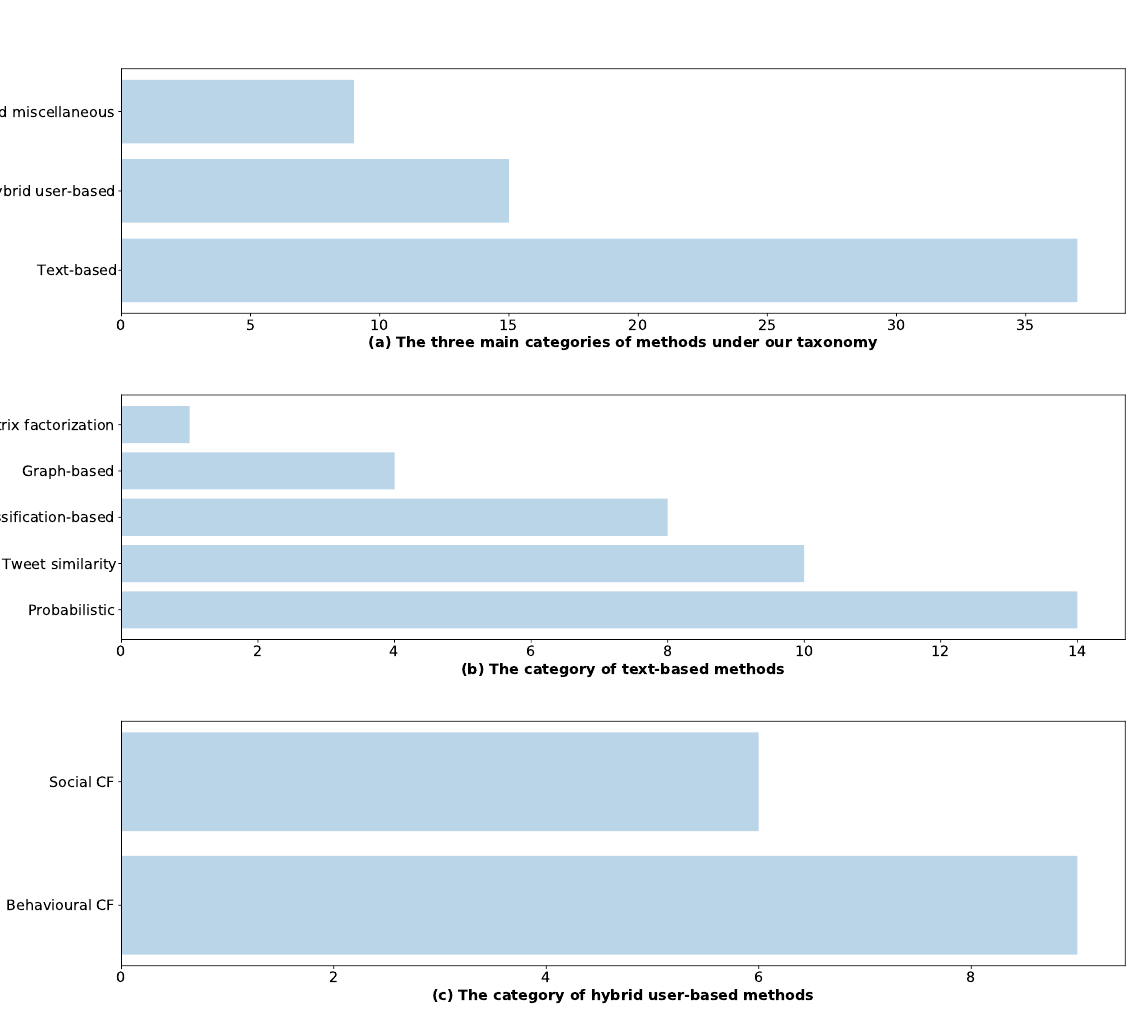
Figure 3. Distribution of the eligible papers on hashtag recommendation from 2010 to 2020 with respect to: ( a ) the three main categories of methods under our taxonomy; ( b ) the category of text-based methods; and ( c ) the category of hybrid user-based